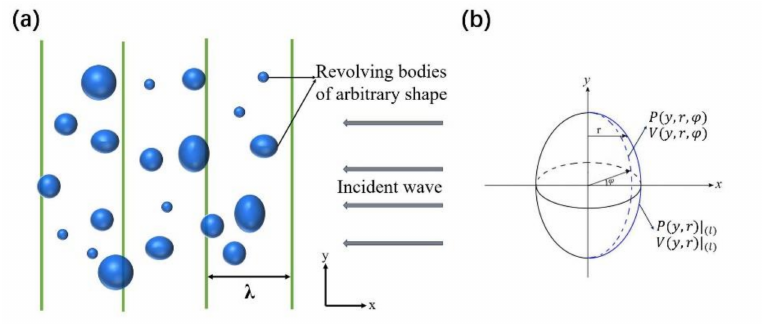
Figure 1. ( a ) A large number of targets are distributed in the x-y plane, and incident waves enter from the x-. ( b ) The distribution of sound pressure and velocity on the surface of any scatter in the sound